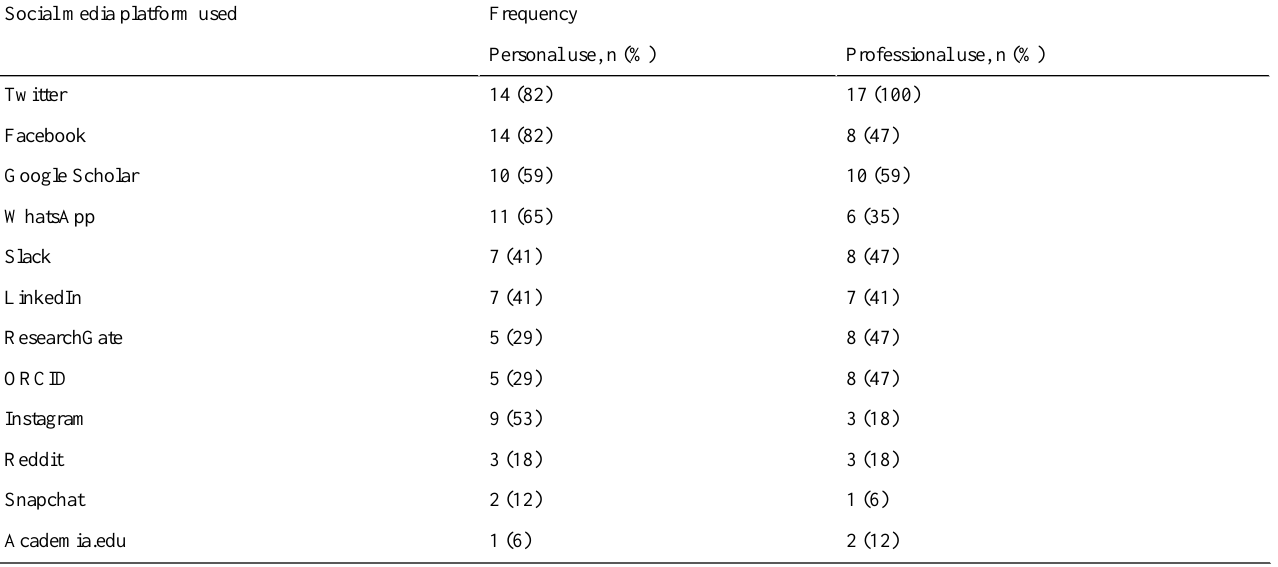
Table 2. Frequencies of social media platforms for personal and professional use.